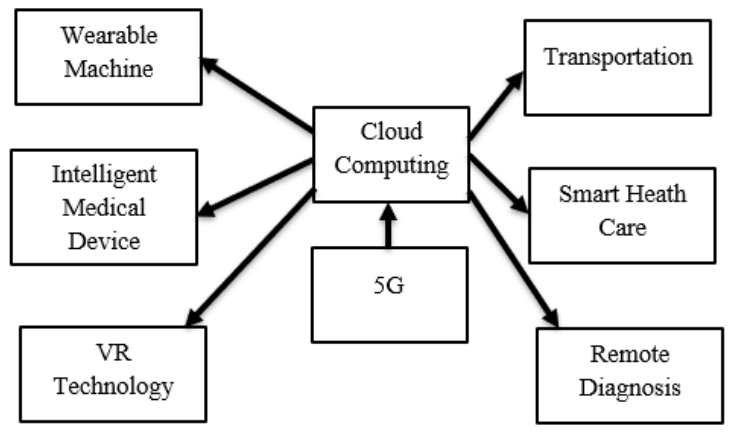
Figure 1. Objectives of Smart hospitals.